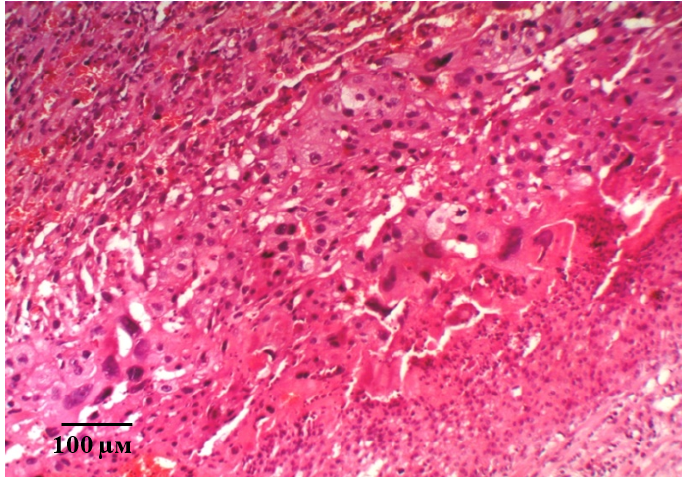
Figure 10. Microphotograph of the placenta on the 21st day of gestation in animals with ADMA-like preeclampsia when pHBSP was administered at the dose of 250 µg/kg. Hematoxylin and eosin staining. Magnification: 200×.